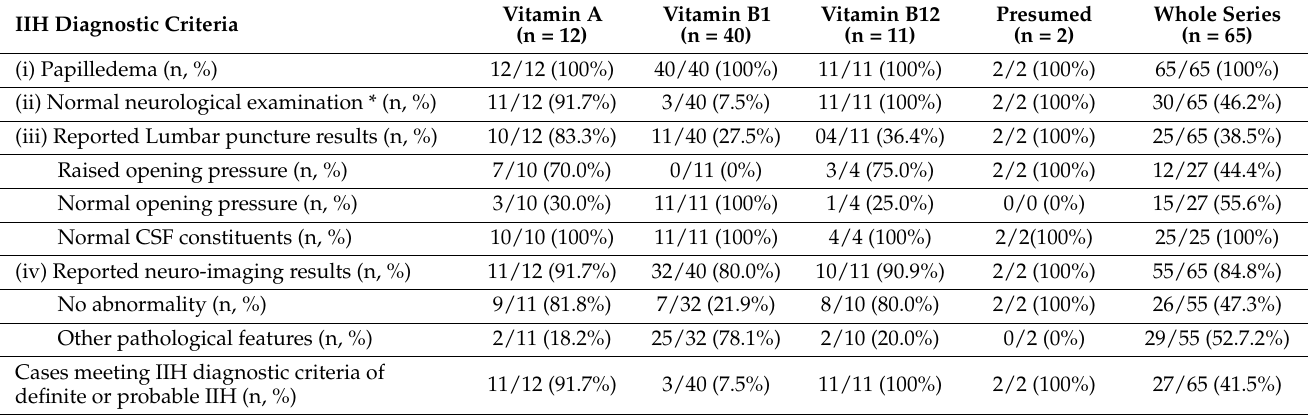
Table 3. Clinical and investigation results compared against IIH diagnostic criteria.